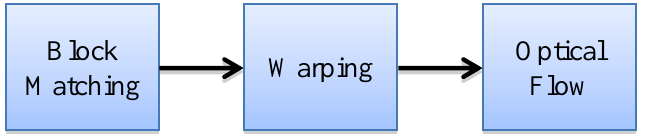
Figure 2. Block matching with sub-pixel accuracy by means of the optical flow scheme.